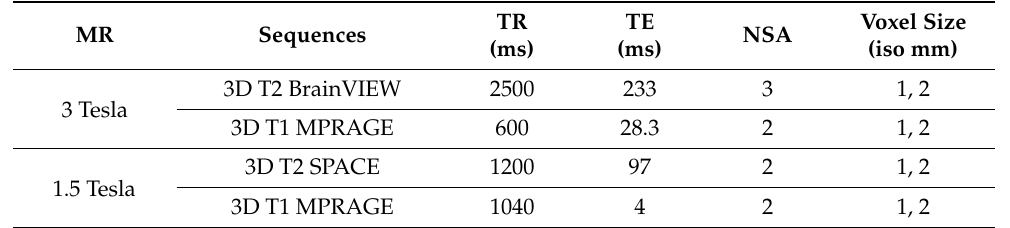
Table 1. Parameters of the sequences used in this work. TR = repetition time, TE = echo time, NSA = number of signals